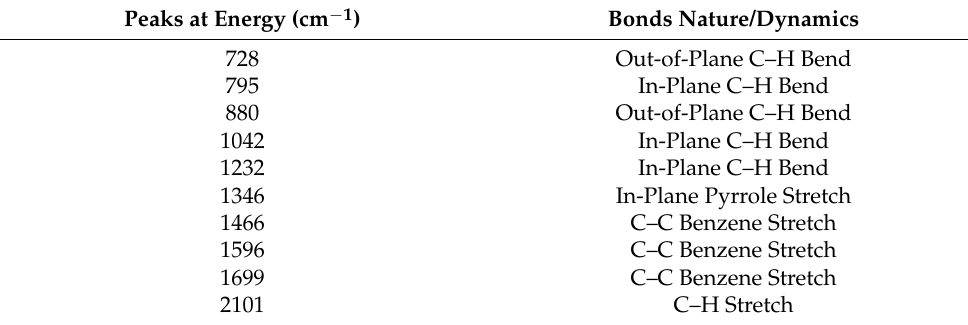
Table 2. Bond dynamics in N749-BD